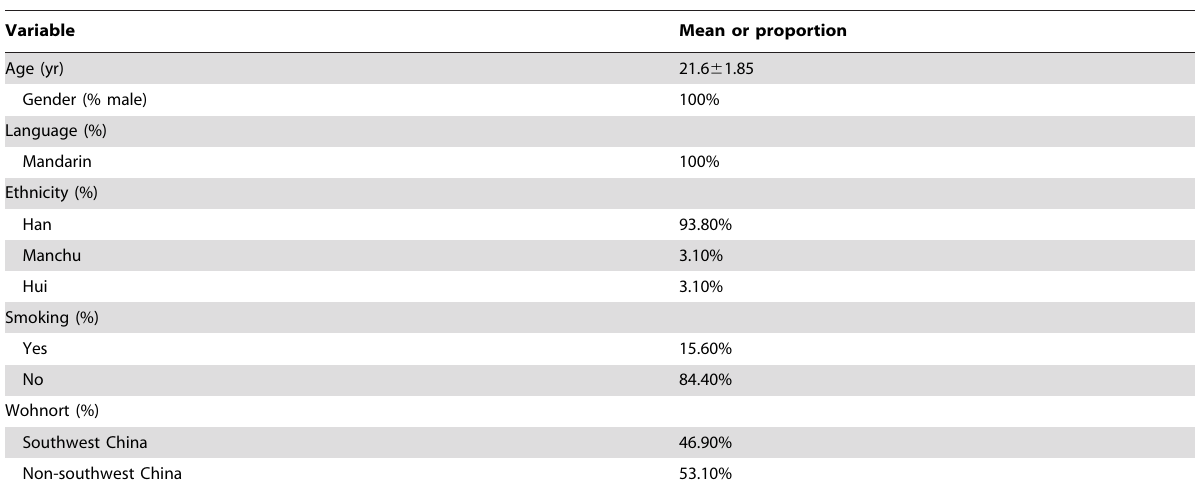
Table 1. Baseline characteristics of the volunteers.